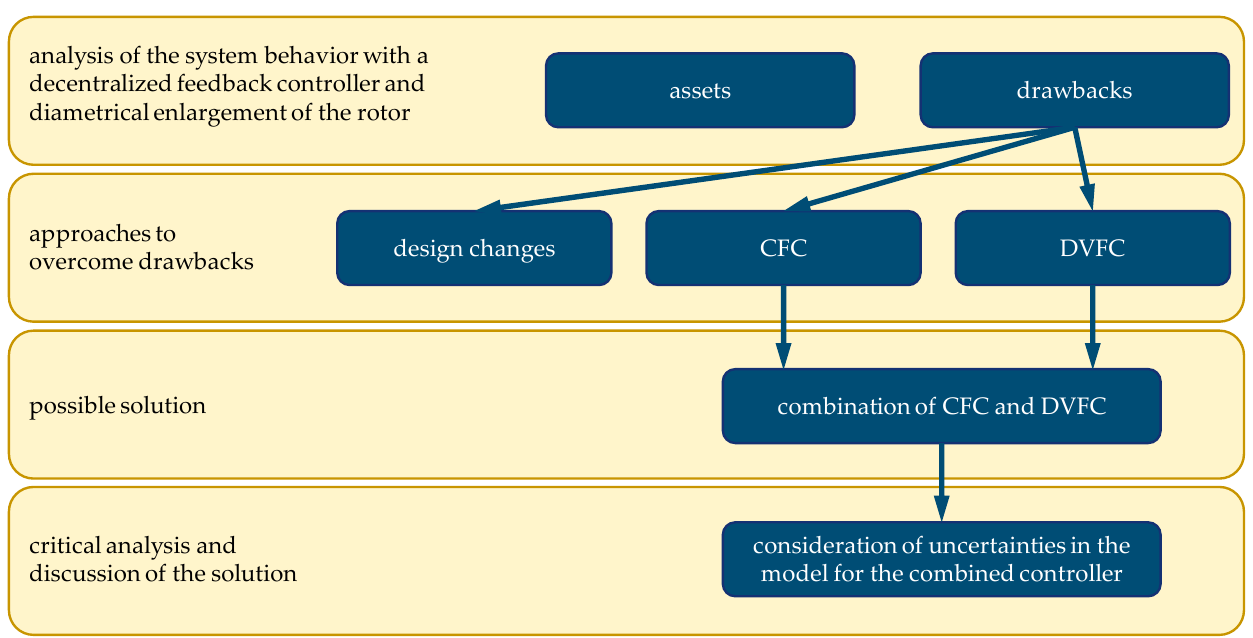
Figure 2. Method used for the investigation of the control of gyroscopic rotors with diametral enlargement.